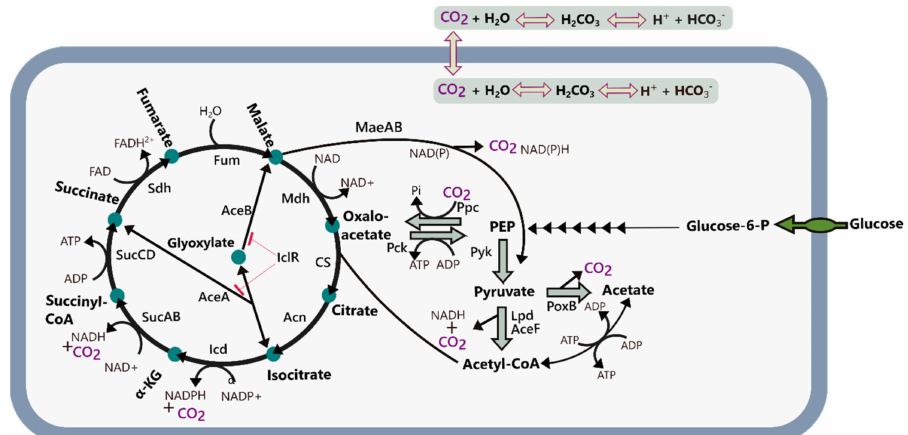
Figure 2. Schematic overview of the central carbon metabolism of E. coli including the CO 2